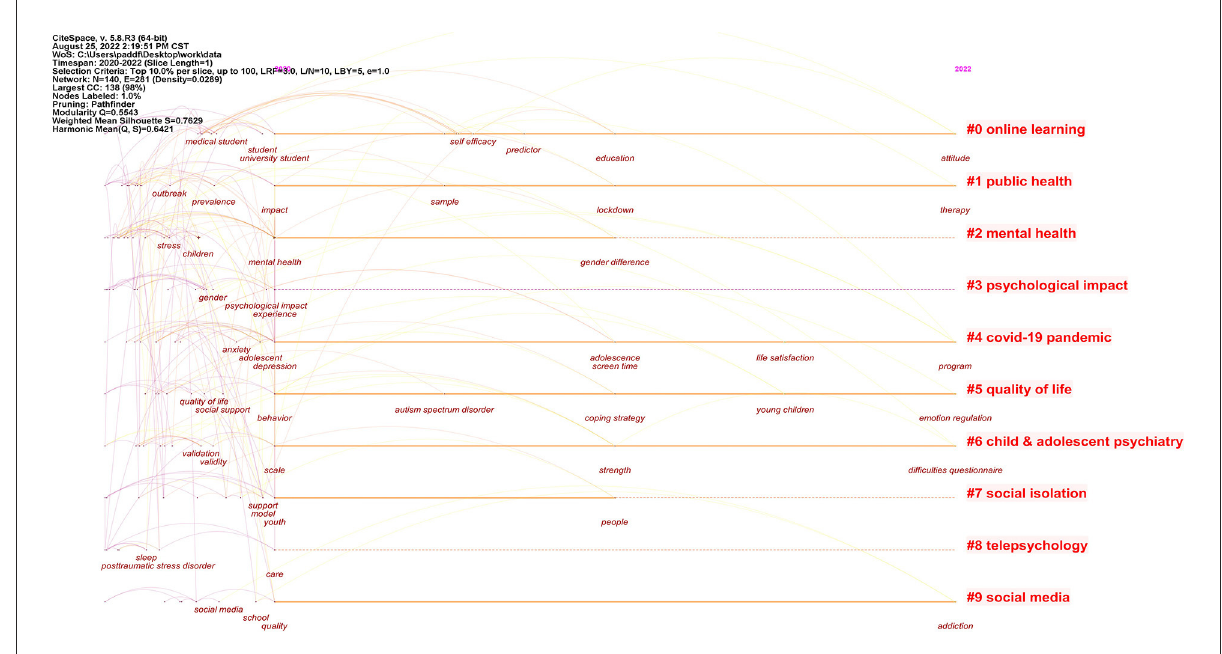
FIGURE8 Timeline visualization of keyword clusters.